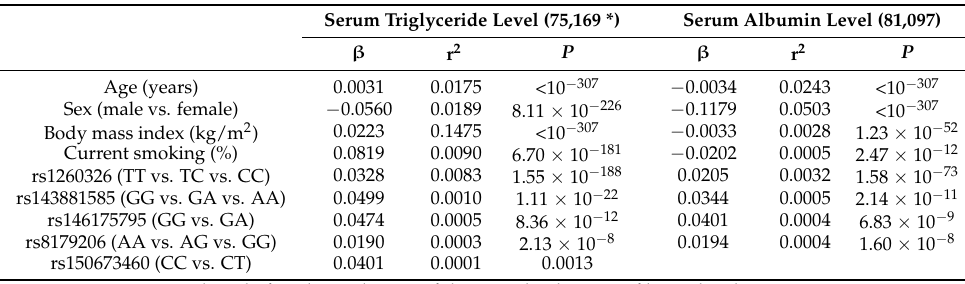
Table 4. Serum triglyceride level and serum albumin level: stepwise linear regression analysis, including